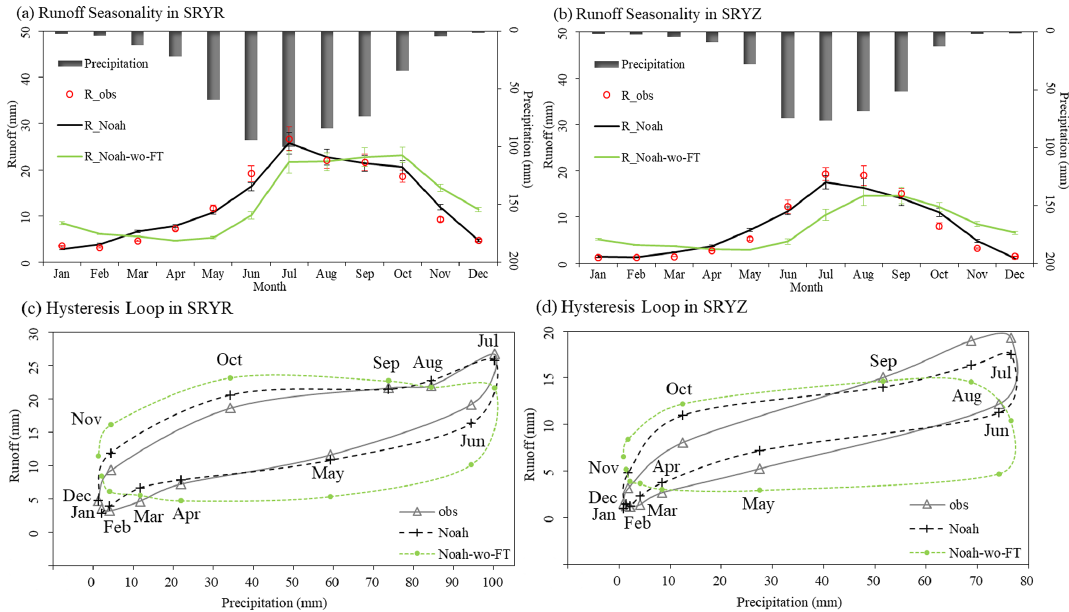
Figure 4. Monthly mean measured (R_obs) and simulated runoff (a, b) and annual precipitation–runoff hysteresis loops (c, d) plotted from measured and simulated runoff produced by the improved Noah LSM with (Noah) and without (Noah-wo-FT) the soil freeze–thaw mech- anism for the source regions of Yellow (SRYR, 1984–2009) (a, c) and Yangtze rivers (SRYZ, 1984–2005) (b, d) . The figure is reproduced from Zheng et al.